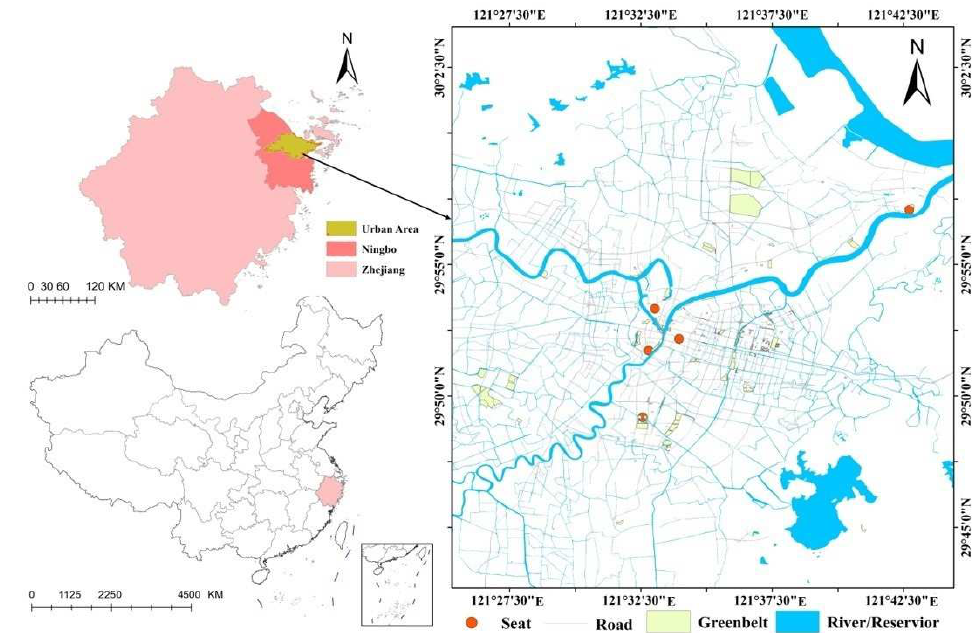
Figure 1. Location of study